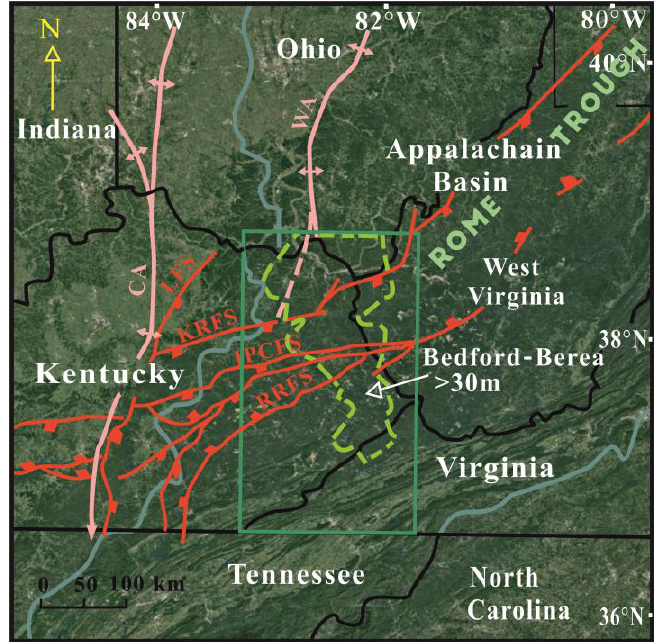
Figure 1. Tectonic map of central Appalachian Basin and the study area. The green box indicates the location of the study area. Thick Bedford – Berea strata (more than 30 m) are distributed in the irregular yellow zone. Pink and red lines indicate arches and faults, respectively. CA = Cincinnati arch; WA = Waverly arch; LFS = Lexington fault system; KRFS = Kentucky River fault system; IPCFS = Irvine – Paint Creek fault system; RRFS = Rockcastle River fault system.